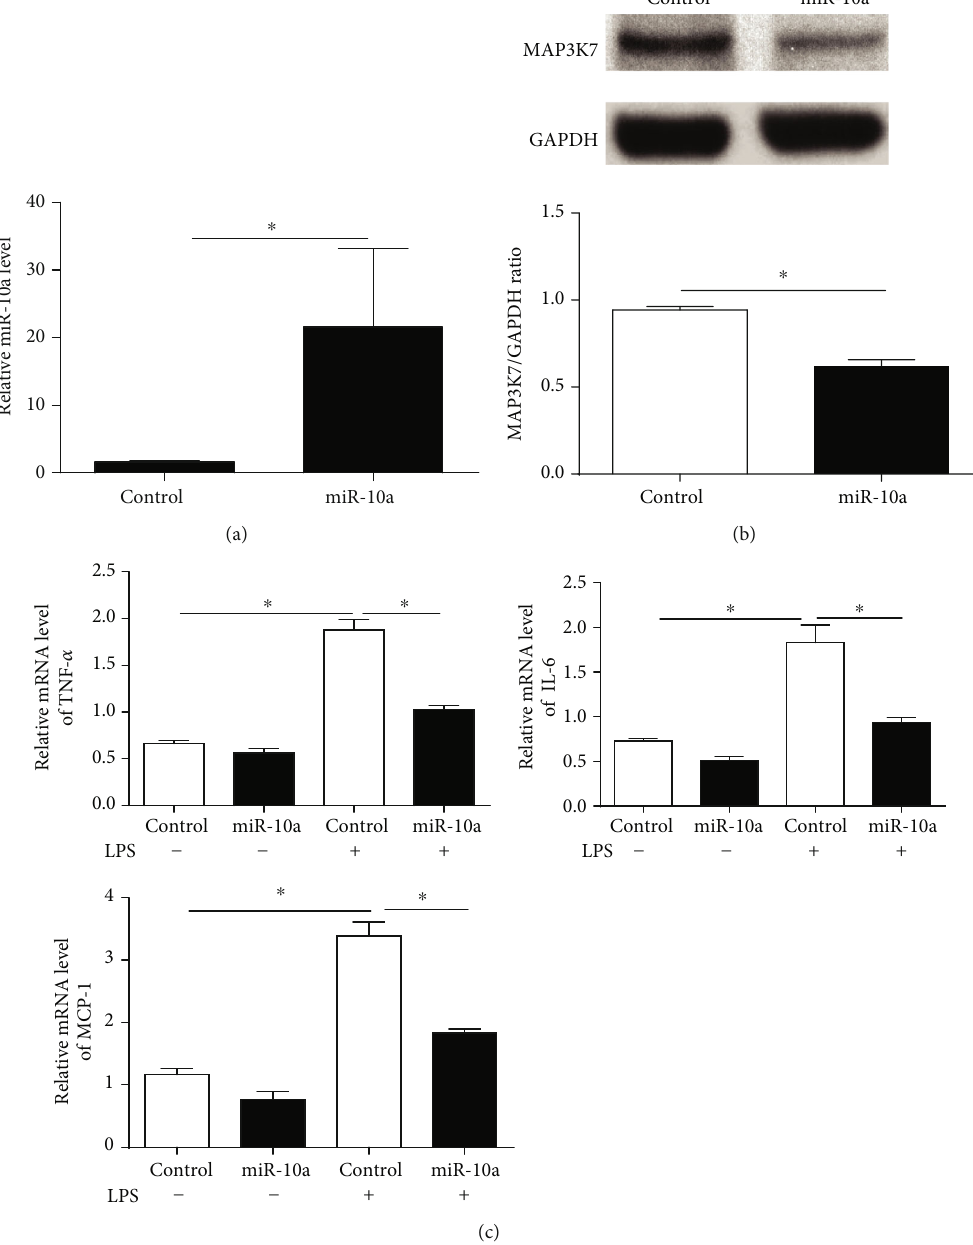
Figure 7: E ff ect of miR-10a overexpression on LPS-induced in fl ammatory cytokine production in monocytes. THP-1 monocytes were transduced with lentiviral miR-10a or miR-control. (a) Four days after the transduction, miR-10a levels in THP-1 cells were determined via qRT-PCR. (b) MAP3K7 expression in transduced THP-1 cells was determined via Western blot analysis. (c) The transduced cells were treated with or without LPS (100ng/ml) for 24h. Levels of IL-6, TNF- α , and MCP-1 in treated cells were assayed via qRT-PCR. Data are presented as mean ± SEM , n = 4 . ∗ p < 0 : 05